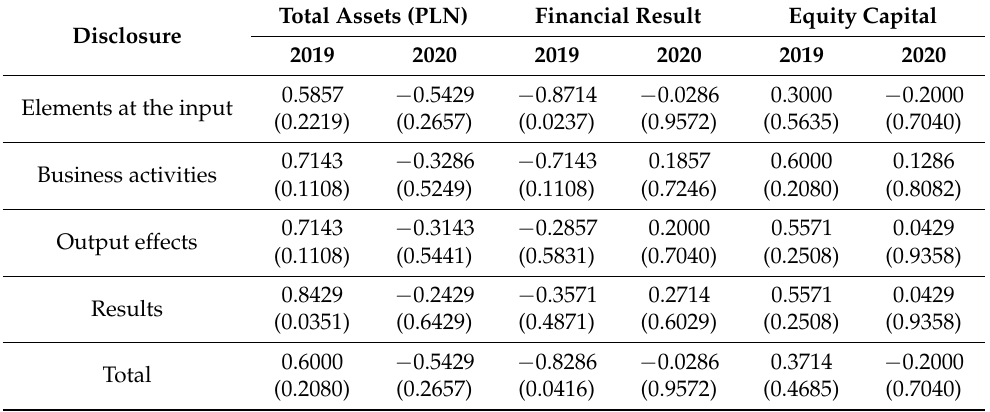
Table 9. Spearman’s rank correlations for all disclosures.